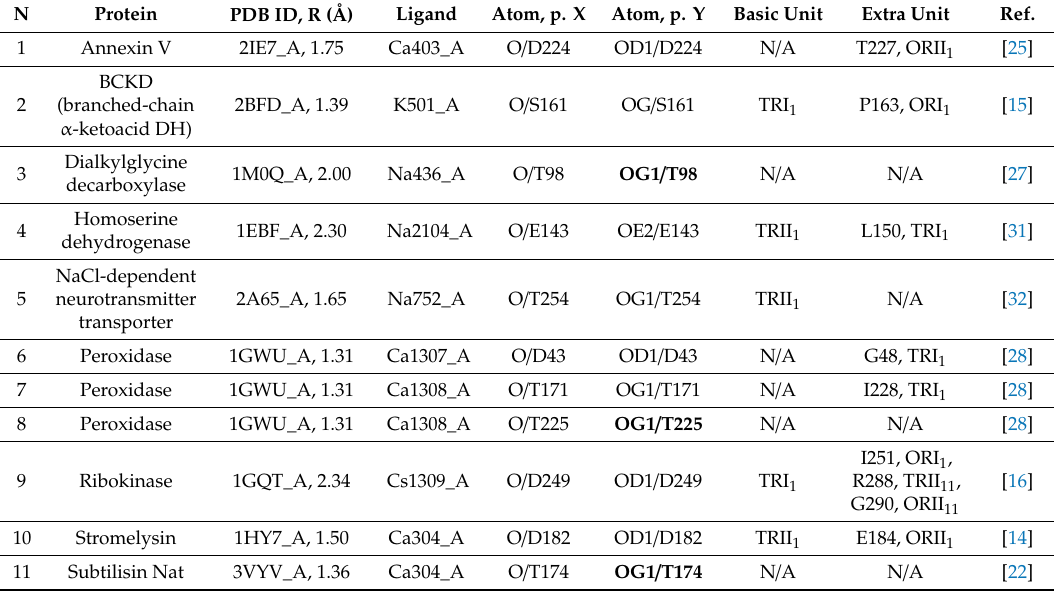
Table 4. Existence of the Clamp n,n unit in the metal cation-binding sites of proteins with “niche” motifs in these